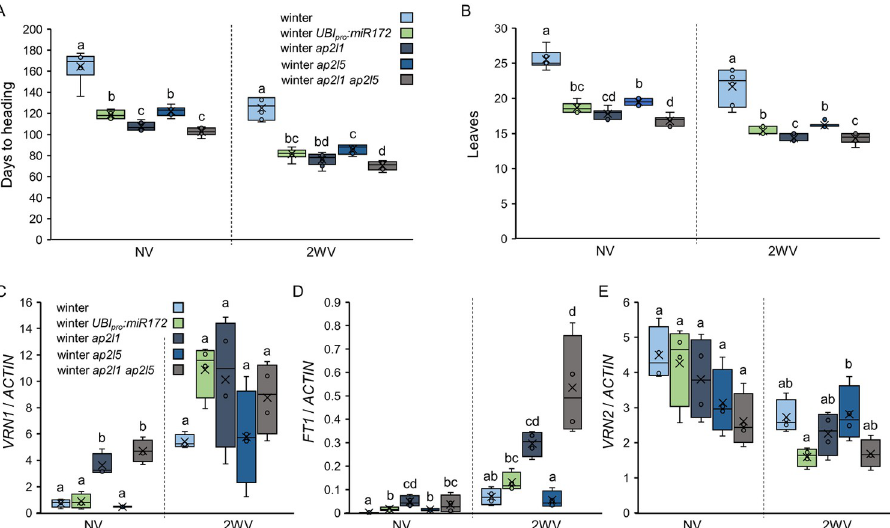
Fig 7. AP2L1 and AP2L5 genes modulate the flowering response in winter plants. ( A-E ) Winter Kronos, winter UBI pro : miR172 , winter ap2l1 , winter ap2l5 and winter ap2l1 ap2l5 grown under LD conditions without vernalization (NV) and with 2 (2WV) weeks of vernalization. Box plots showing ( A ) days to heading or ( B ) number of leaves in